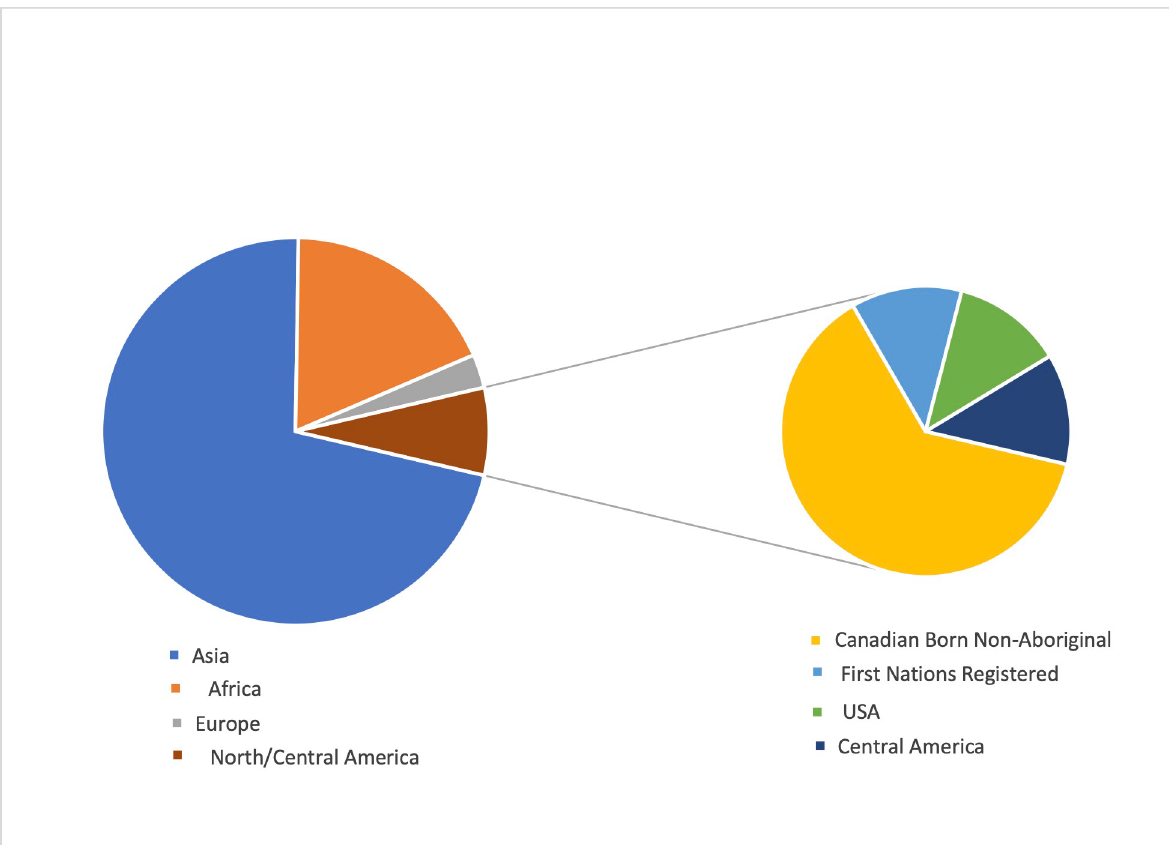
Fig 2. Distribution of Hr-TB by region and